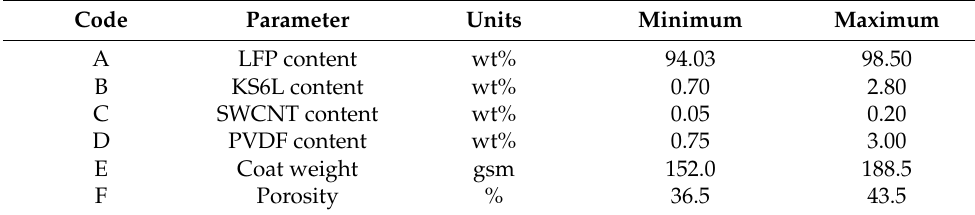
Table 1. Inputs to the